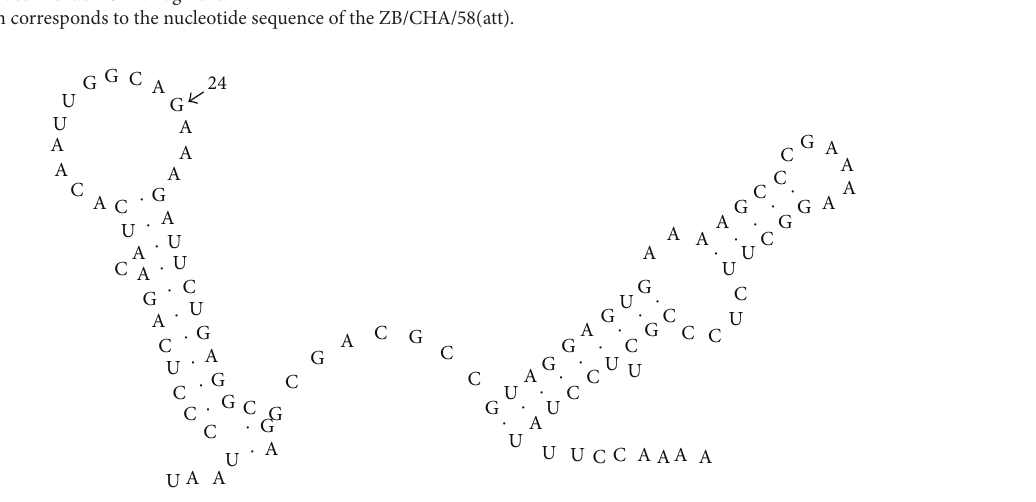
Figure 2: The 3 󸀠 -UTR RNA secondary structure of FMDV ZBCF22